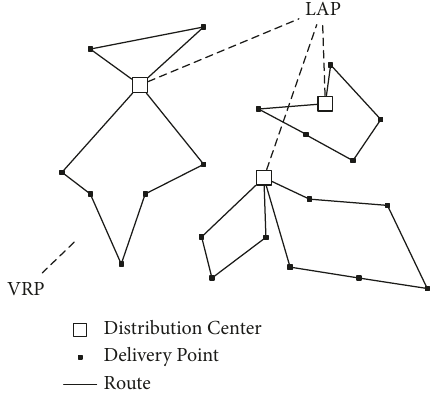
Figure 1: Problem structure of LAP, VRP, and